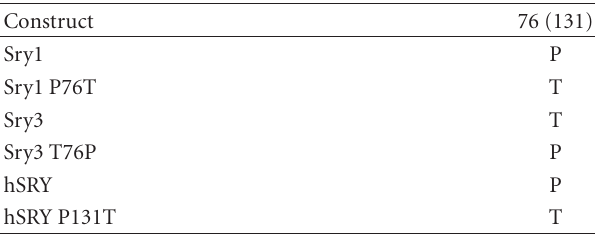
Table 1: Sry expression constructs of rat and human showing the amino acid at 76 in rat or 131 in